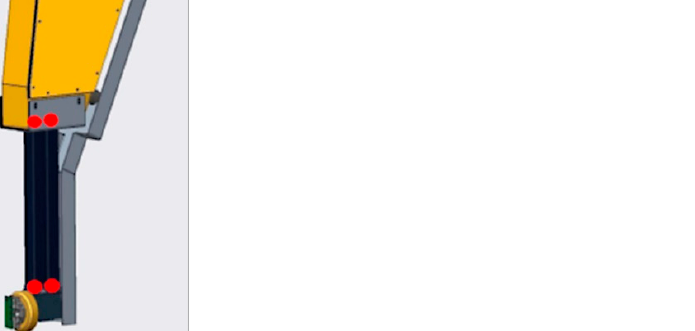
Figure 7. CAD design of microprobe integration in a roll measuring instrument.